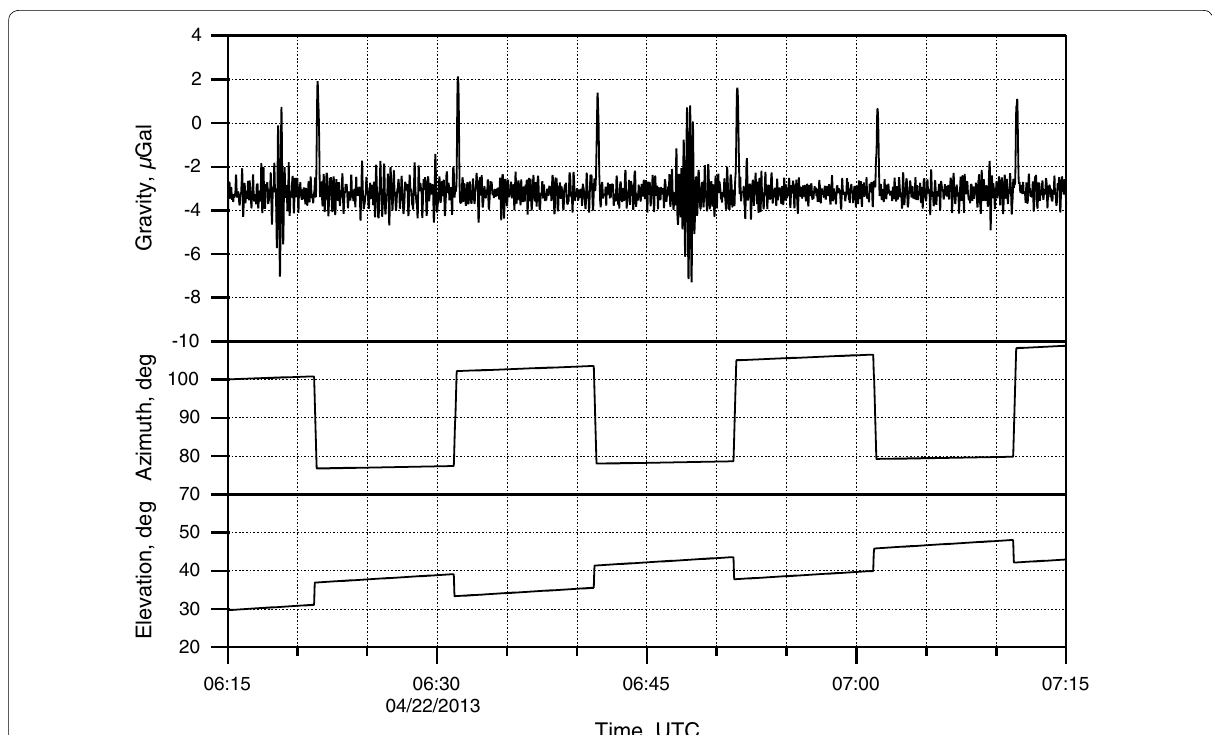
Fig. 3 Typical effects of the movement of the VLBI antenna on the superconducting gravimeter at the VERA Ishigakijima